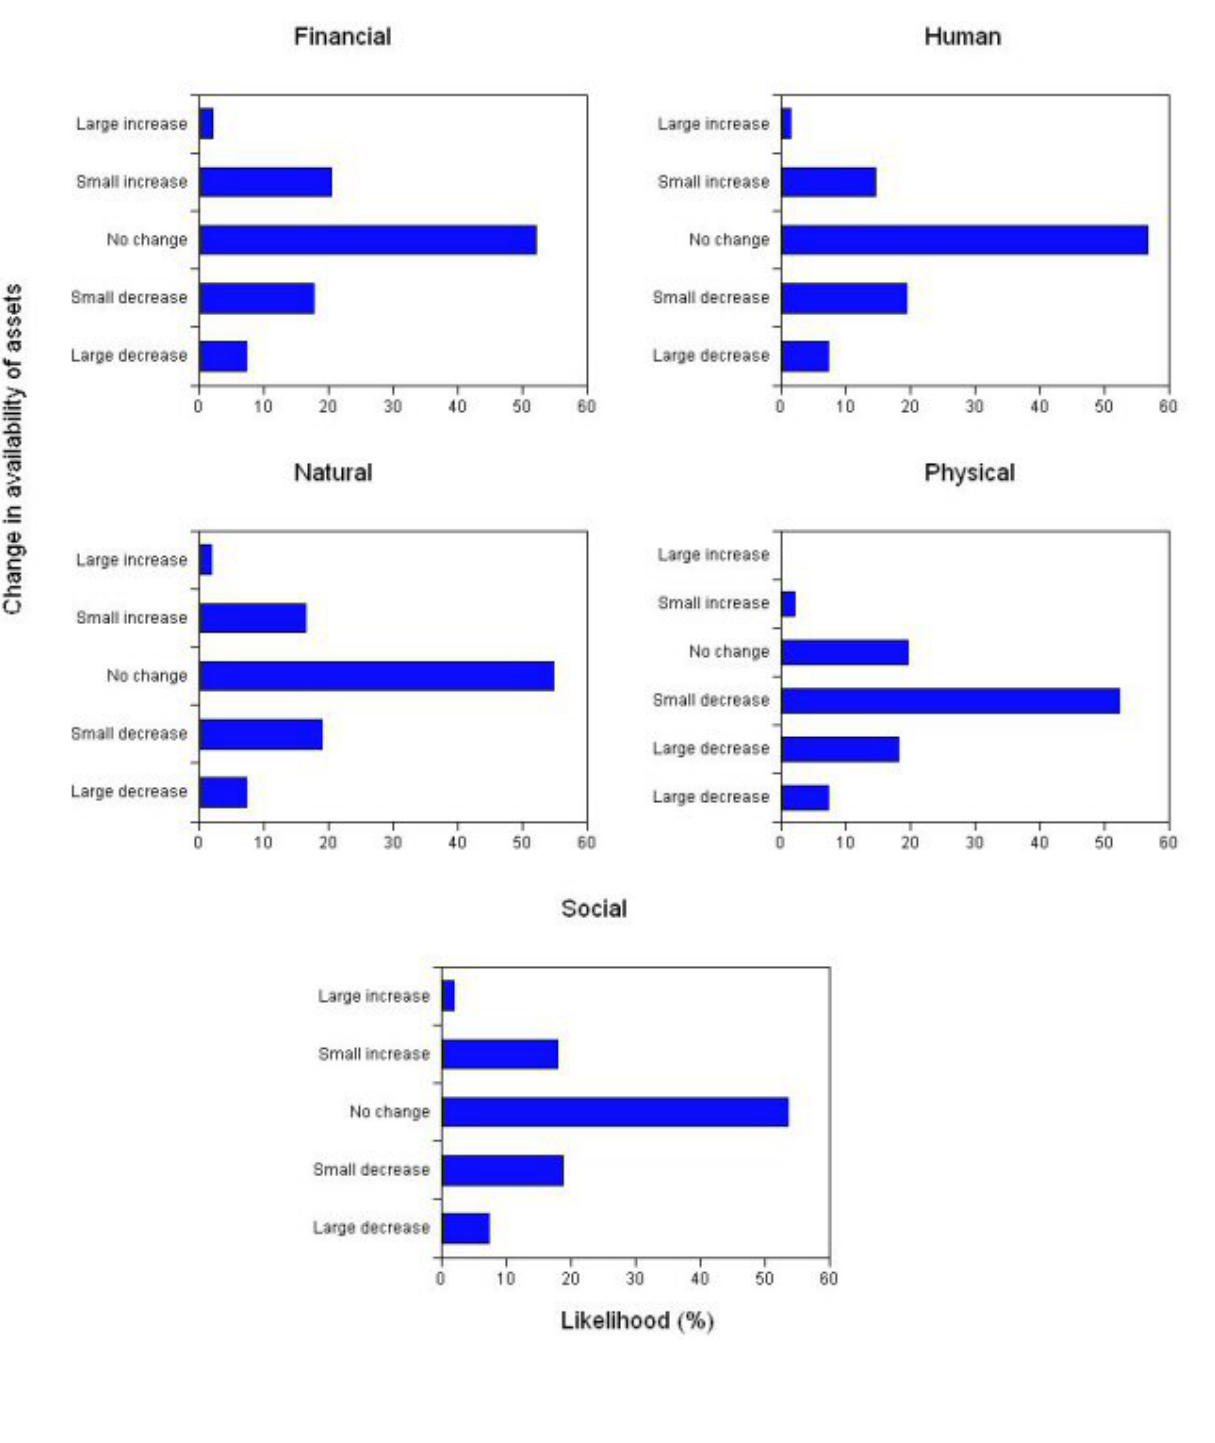
Fig. A7.3. The impacts of commercialization on availability of assets, as predicted by the BBN, for the case study of Jipi Japa (El Carmen Surutú). These outputs were generated by instantiating the network with factor values for these individual case studies (see